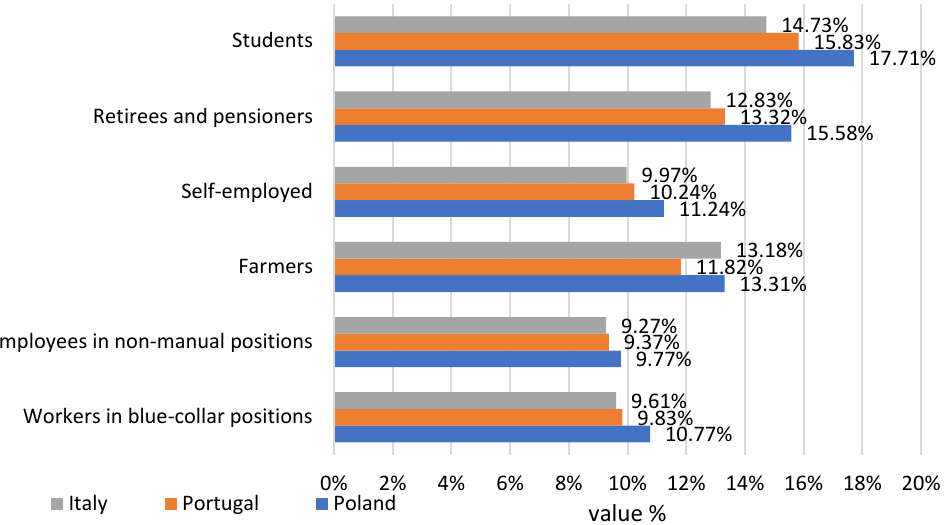
Figure 1. Energy expenditure in the household budget broken down by professional groups (per person).